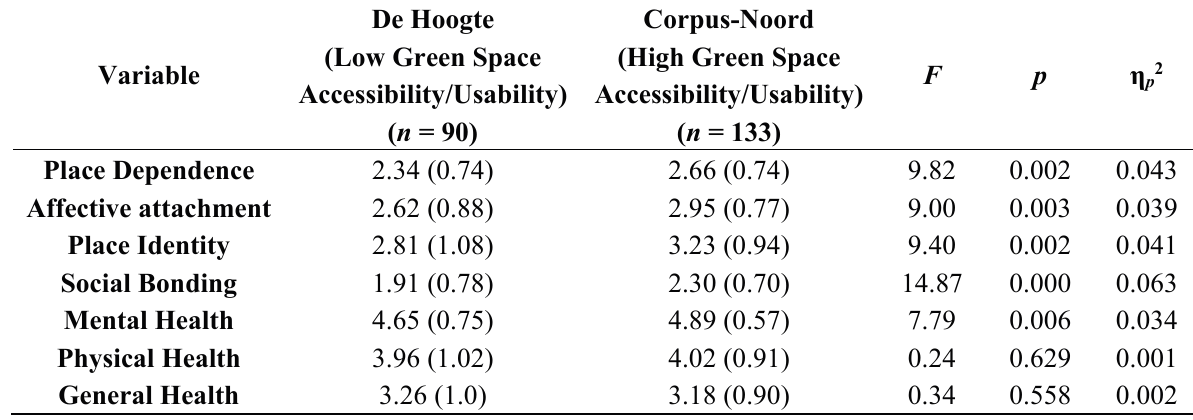
Table 5. Mean scores on dimensions of green space attachment and health measures in the two neighborhoods (range 1–5, standard deviations between